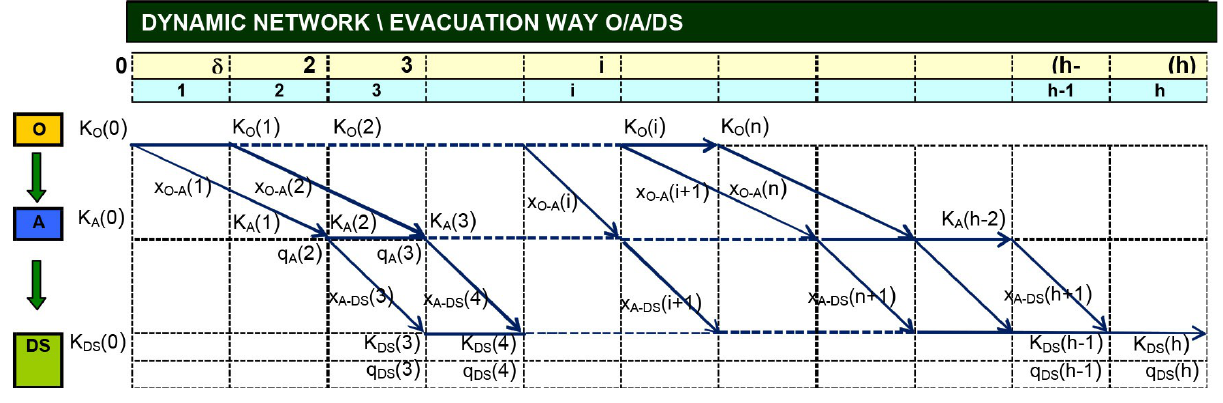
Figure 7. Dynamic network values for a single